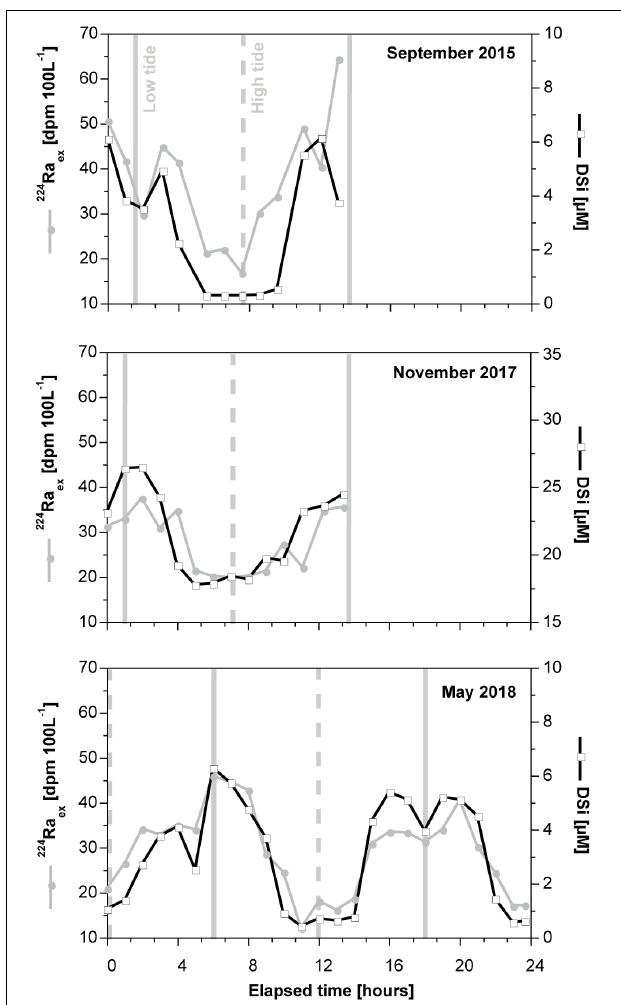
FIGURE 4 | Tidal DSi and 224 Ra ex dynamics in the water column of the Spiekeroog tidal basin, with highest concentrations/activities around low tide when submarine discharge of DSi/Ra-rich groundwater is highest. The vertical solid and dashed lines indicate low tide and high tide, respectively. The water level changes smoothly depending on the tidal state. In contrast, tidal variations of DSi and 224 Ra ex show a less smooth pattern because the tidal flat area consists of several tidal flats, which slightly differ in SGD fluxes and DSi endmember